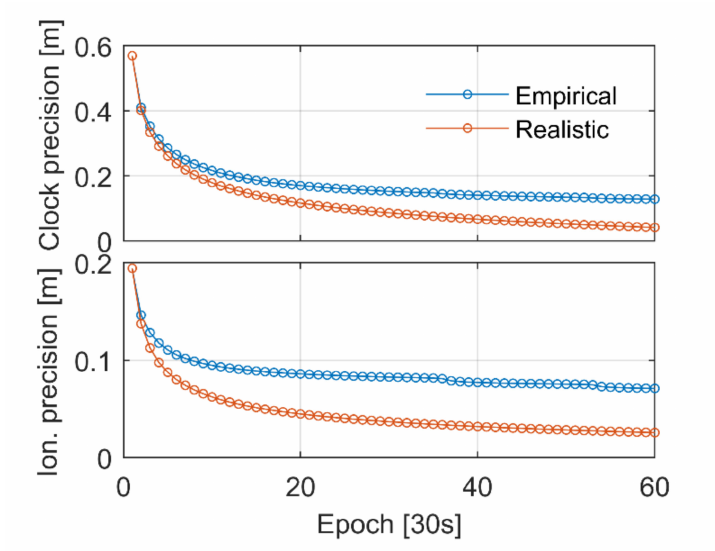
Figure 12. Clock and ionosphere precision in GPS+BDS+Galileo dual-frequency ionosphere-weighted RTK positioning with a realistic and an empirical stochastic model of RCB process noise. The empirical stochastic model refers to the one that sets the STD of RCB process noise as 10 m. The data were collected from the baseline IGG1–IGG2 on DOY 270,